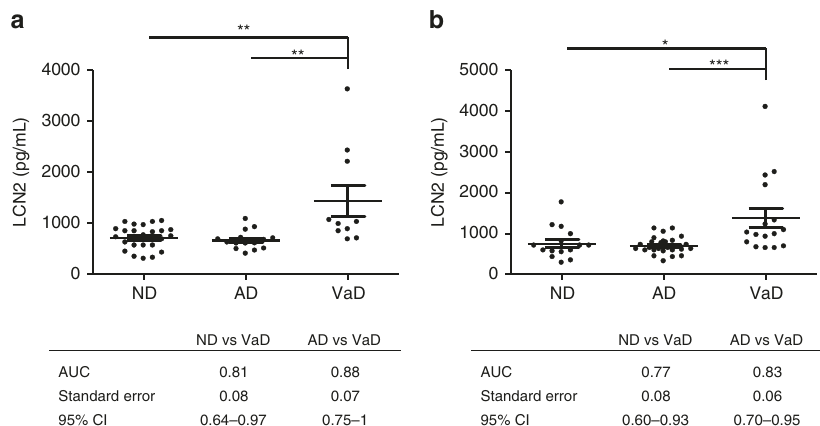
Fig. 2 Diagnostic accuracy of CSF LCN2 in the discrimination of VaD and AD (cohorts 2 and 3). a Cohort 2: LCN2 concentrations in non-primarily neurodegenerative and non-ischemic neuropsychiatric diseases (ND, n = 24), Alzheimer ’ s disease (AD, n = 15), and vascular dementia (VaD, n = 10). Area under the curve (AUC) derived from receiver operating characteristic (ROC) curves, Standard Error, and 95% CI in the comparative analysis of VaD versus ND and AD. b Cohort 3: LCN2 concentrations in ND (n = 15), AD (n = 27), and VaD (n = 16). AUC derived from ROC curves, Standard Error, 95% CI in the comparative analysis of VaD versus ND and AD. Differences between groups were analysed with Tukey contrasts using linear regression models controlled for age and sex. * p < 0.05, ** p < 0.01, *** p <